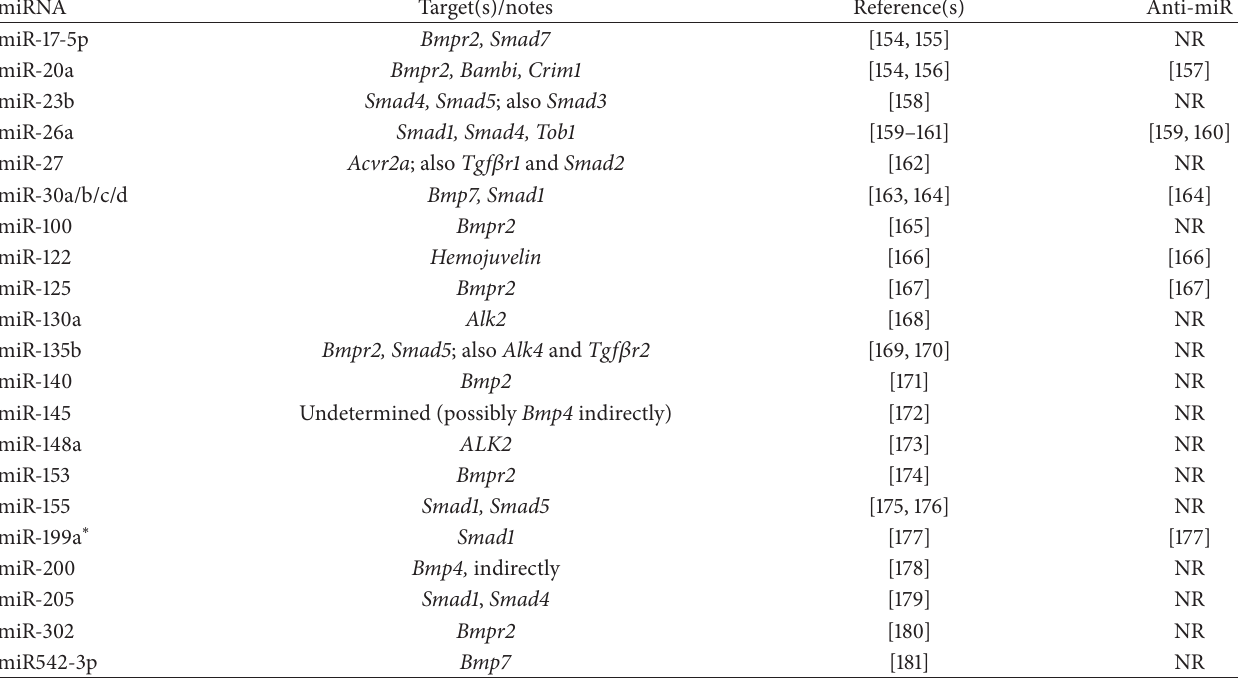
Table 2: Examples of microRNAs targeting BMP pathway components and their inhibition via anti-miR RNA interference. miRNA